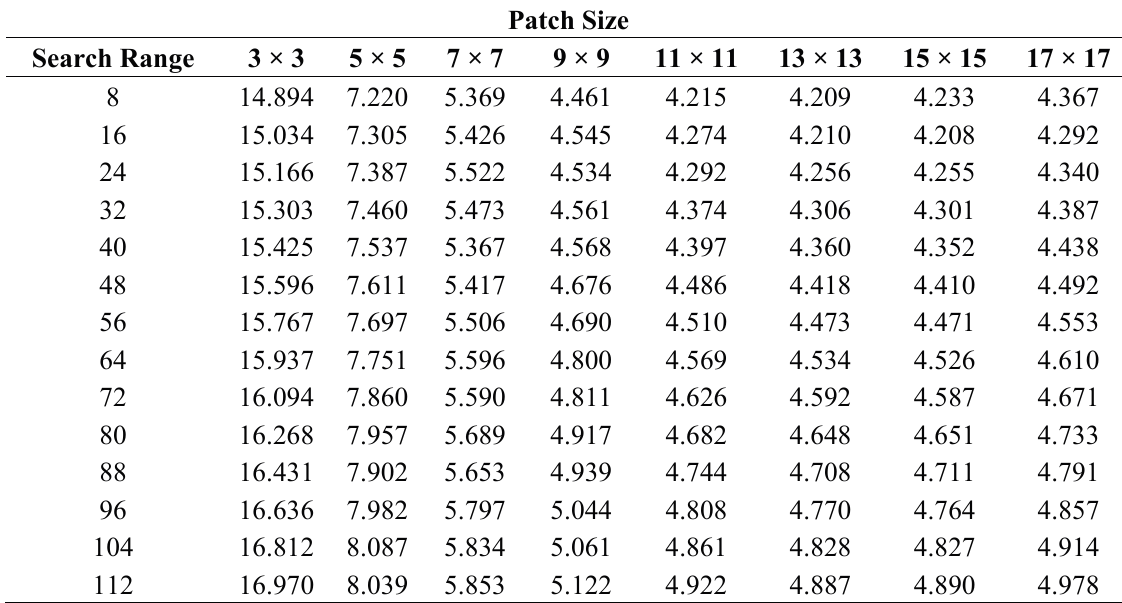
Table 3. Mean computational time vs. small patch size.